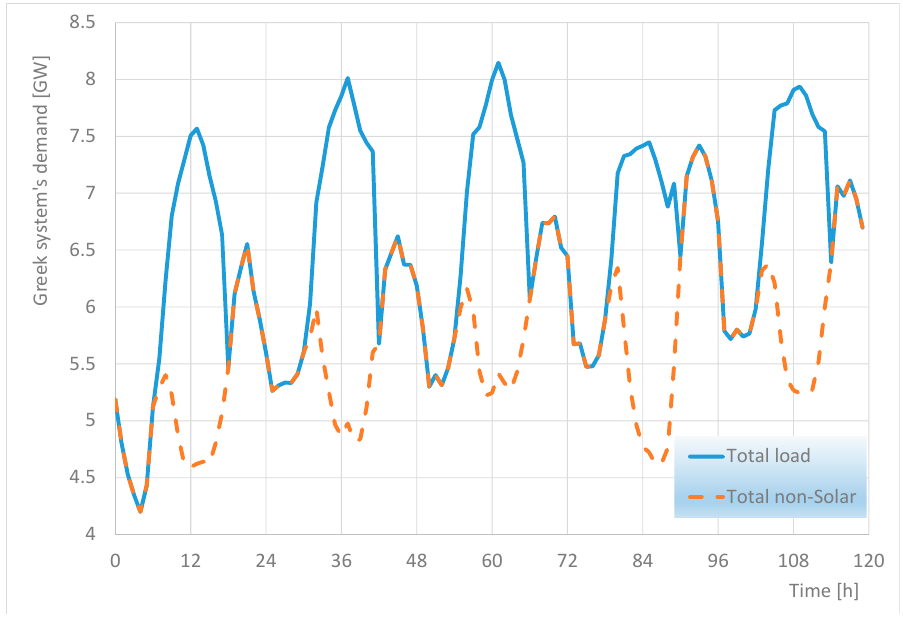
Figure 14. Load demand of the Greek system in the period 11–15 July 2022: The demand covered by non-solar power sources is indicated for comparison.